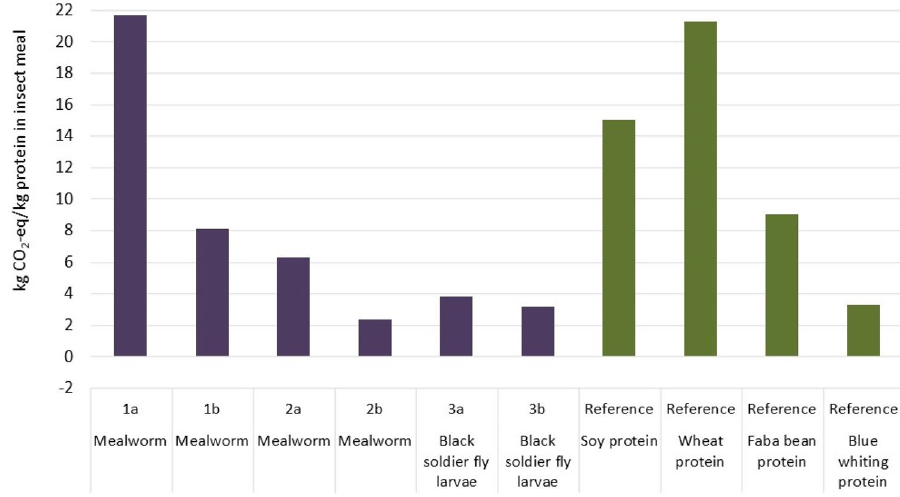
Fig. 6 Climate change results for insect meal (per kg protein delivered to the west coast of Norway) compared with refer- ence products (per kg deliv- ered to feed mill in